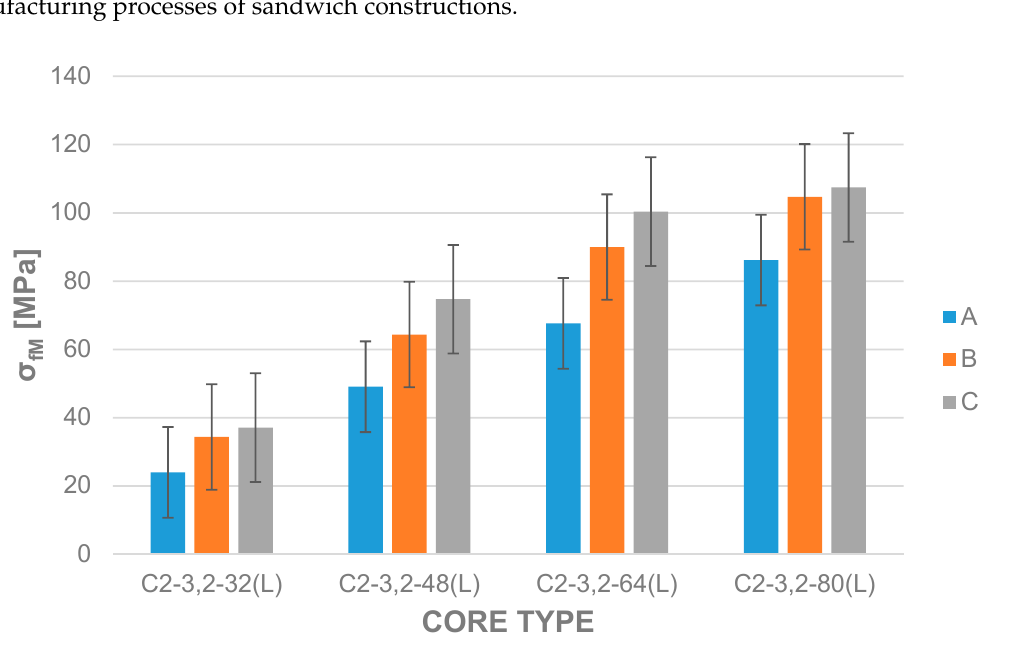
Figure 10. Influence of honeycomb density (32, 48, 64, 80) kg·m − 3 on the bending modulus of sandwich constructions A–C (L orientation). In evaluations of the influence of honeycomb cell sizes, constructions made with honeycomb of 64 kg·m − 3 density and cell sizes of 3.2, 4.8, and 6.4 mm were compared. Regarding the evaluated A, B, and C constructions, the highest values of strength were found at the constructions with the cell size of 4.8 mm, while in the constructions with the cell size of 6.4 mm, the values were lowest. A similar trend was noted for the bending modulus. In terms of the coating influence effectivity in the sandwich constructions in the L direction, the average increases in strength of 22.81% (3.2 mm mesh size), 25.32% (4.8 mm mesh size), and 21.44%